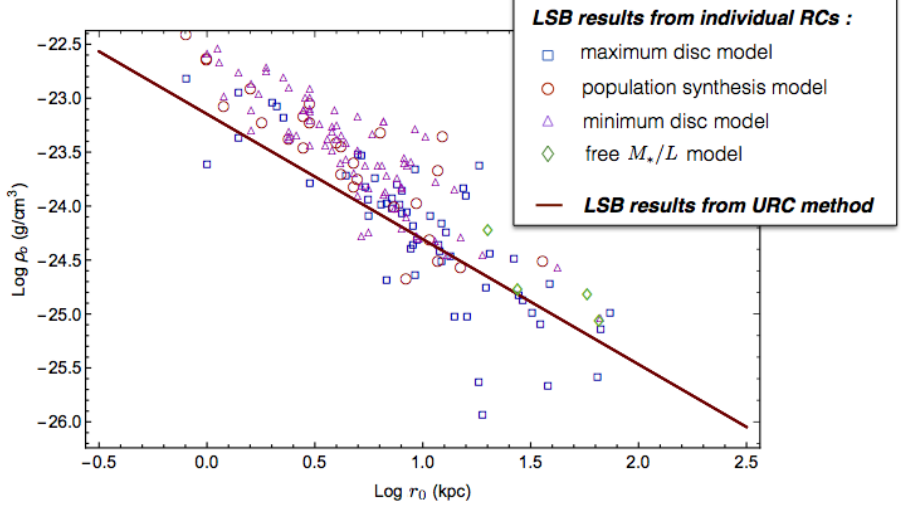
Figure 20. Same legend of Figure 11: the central density of the DM halo vs. its core radius. Image reproduced from